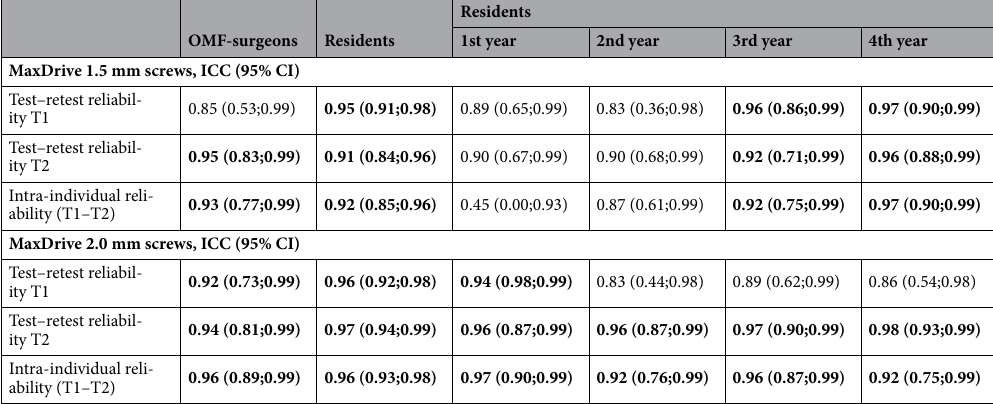
Table 3. Test–retest reliability (at T1 and T2) and intra-individual reliability between T1 and T2. The bold values indicate sufficient reliability (i.e., ICC ≥ 0.7). ICC intra-class correlation coefficient, 95% CI 95% confidence interval, OMF-surgeons oral and maxillofacial surgeons.